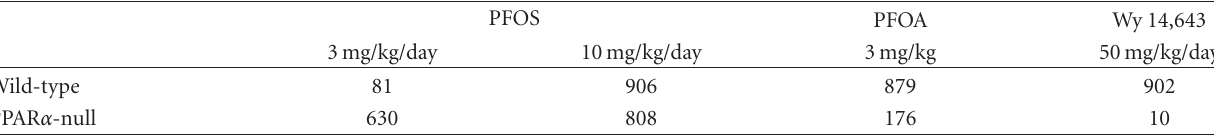
Table 2: Number of fully annotated genes altered by PFOS, PFOA 1 , or Wy-14,643 1 in wild-type and PPAR α -null mice ( P ≤ . 0025) 2 . PFOS PFOA Wy 14,643 3mg/kg/day 10 mg/kg/day 3 mg/kg Wild-type PPAR α -null